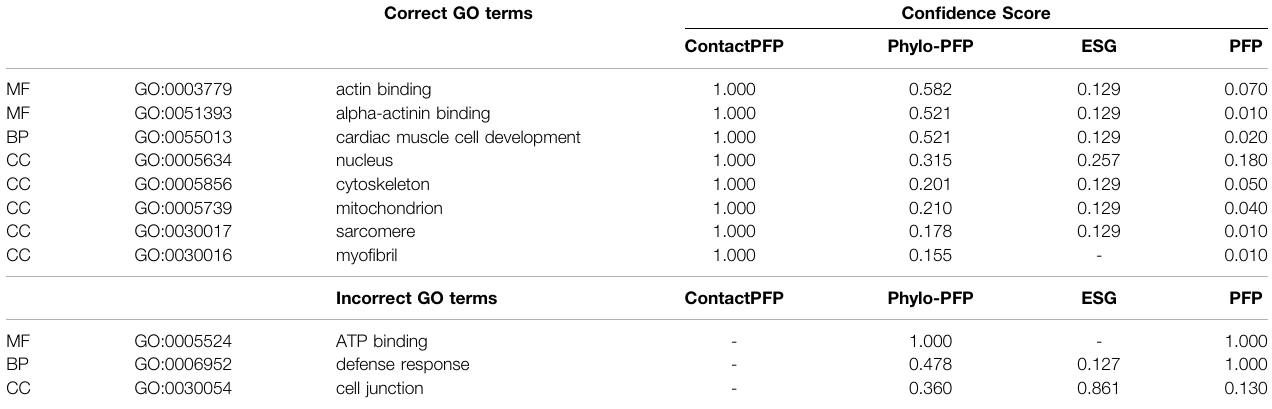
TABLE 4 | Predicted GO terms for Leucine-rich repeat-containing protein 10 (UniProt ID: